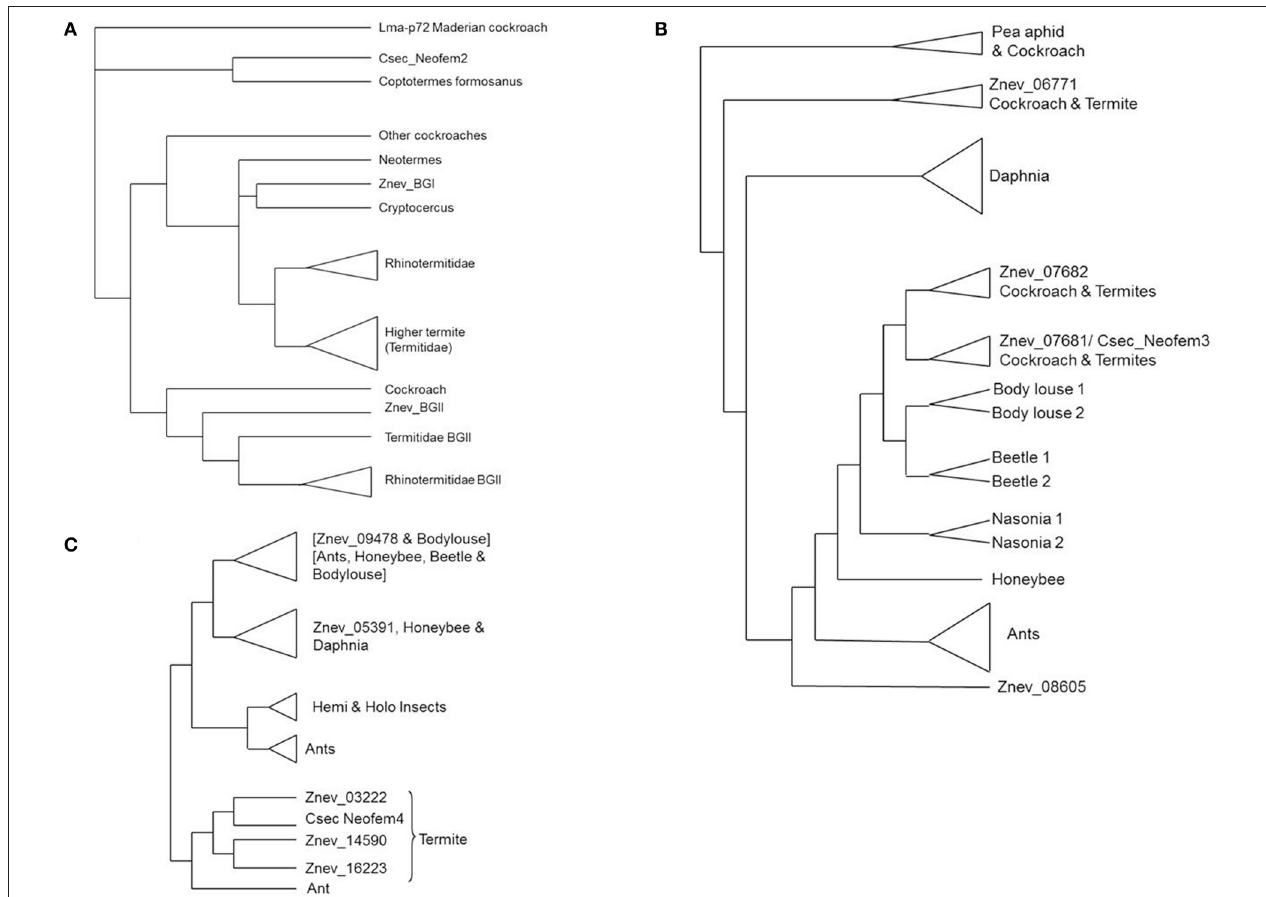
FIGURE 2 | Simplified gene trees of Neofem genes. Cladograms of (A) Neofem2 -related beta-glucosidases (after Shimada and Maekawa, 2014), (B) Neofem3 -related vitellogenins (after Terrapon et al., 2014), and (C) Neofem4 -related Cytochrome P450 genes (after Terrapon et al., 2014). Beetle, Tribolium castaneum ; body louse, Pediculus humanus ; Cryptocercus, Cryptocercus punctulatus ; Csec, Cryptotermes secundus ; Daphnia, Daphnia pulex ; honeybee, Apis mellifera ; Maderian cockroach, Rhyparobia maderae ; Nasonia, Nasonia vitripennis ; pea aphid, Acyrthosiphon pisum ; Znev, Zootermopsis nevadensis .